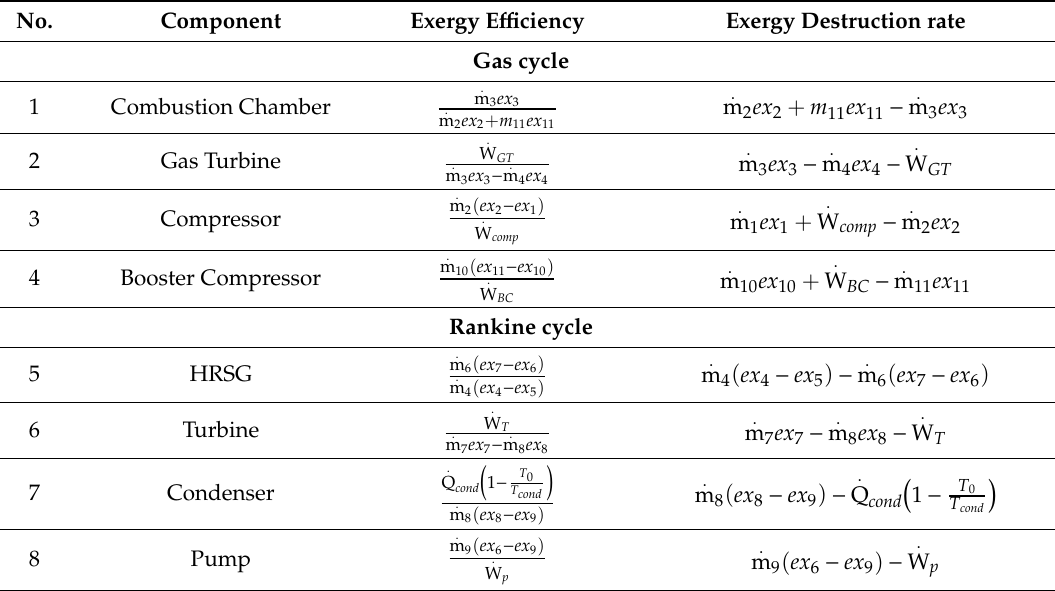
Table 5. Equations of exergy balance and exergy destruction rate for the GT-HRSG integrated system